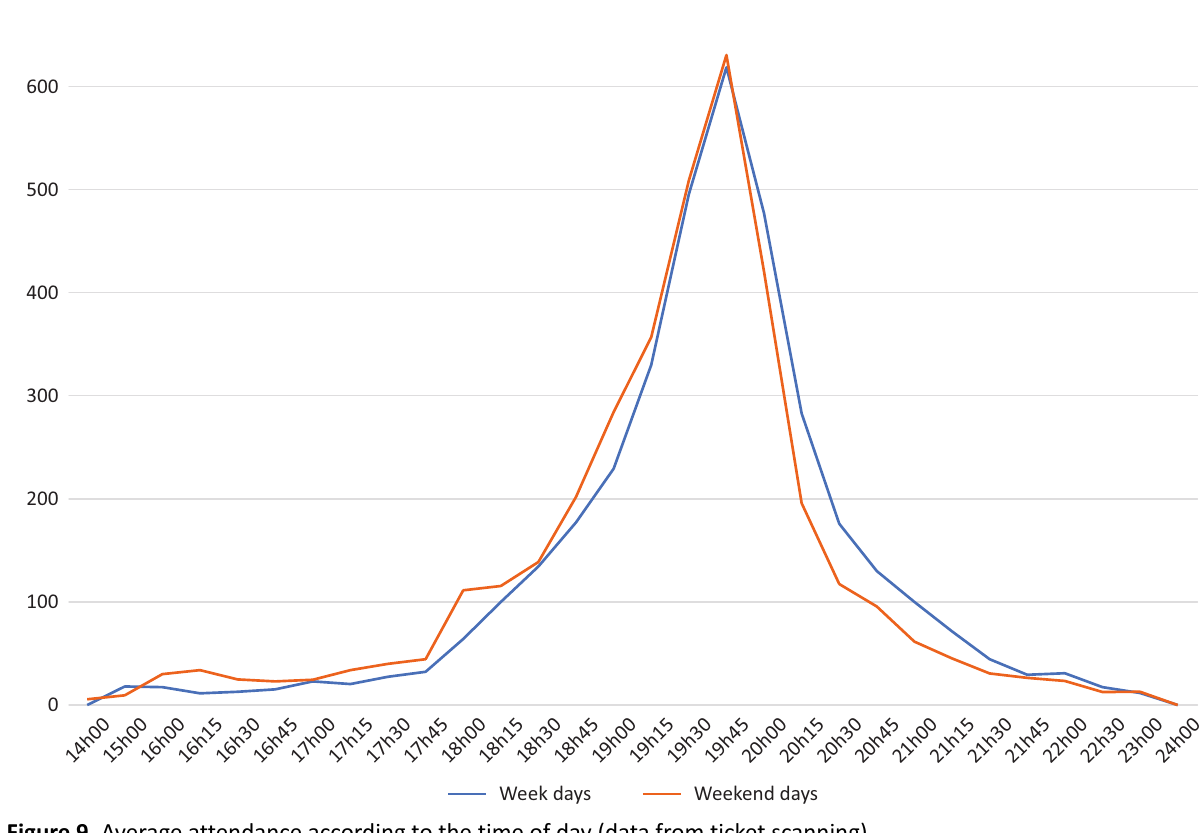
Figure 9. Average attendance according to the time of day (data from ticket scanning).